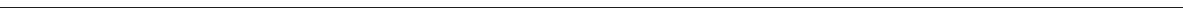
FIGURE 7 | values for the respective time points. (C) PHA-767491 does not impair Ca 2 + flux. Peripheral lymphocytes were either pre-treated with PHA-767491 or not and were incubated with biotinylated anti-CD3 antibodies. Lymphocytes were first cross-linked using streptavidin, followed by an exogenous addition of CaCl 2 solution, and finally treated with ionomycin. (D) PHA-767491 affects TCR recycling in stimulation assays. Peripheral lymphocytes and thymocytes were stimulated with plate-bound anti-CD3 antibody or anti-CD3/CD28 beads, respectively, for 3 or 17h. Values indicated in the histograms represent the MFI. (E) Cdc7 association with Dbf4 and MCM2 is reduced in TCR stimulated T cells treated with PHA-767491. Serum-starved Jurkat cells that were not-treated (–) or treated ( + ) with PHA-767491 were seeded into wells coated with plate-bound anti-CD3 antibodies and incubated for the indicated times and lysed. Anti-Dbf4 antibodies were used to immunoprecipitate Dbf4 from the cell lysates. Samples were immunoblotted for immunoprecipitated Dbf4 and co-immunoprecipitated Cdc7 and MCM2. Data shown is representative of at least three independent experiments. Bar charts are represented as mean ± SEM. Statistical significance was determined by